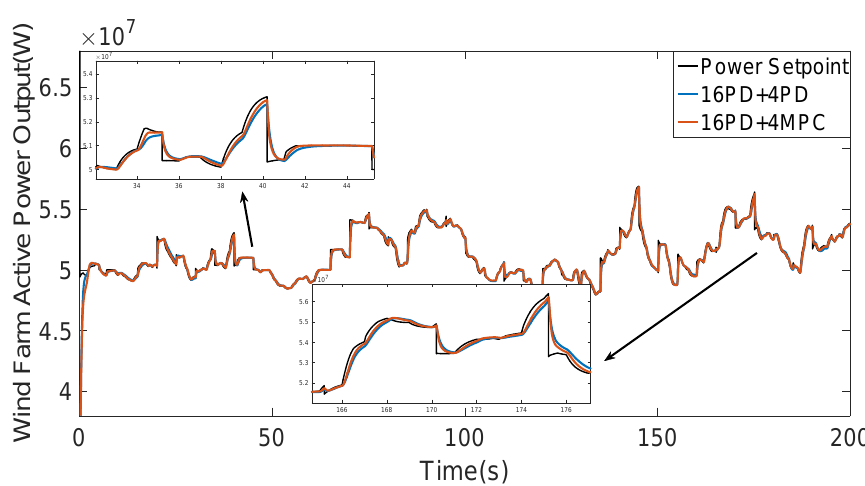
Figure 15. Wind farm power output under a time varying power demand.